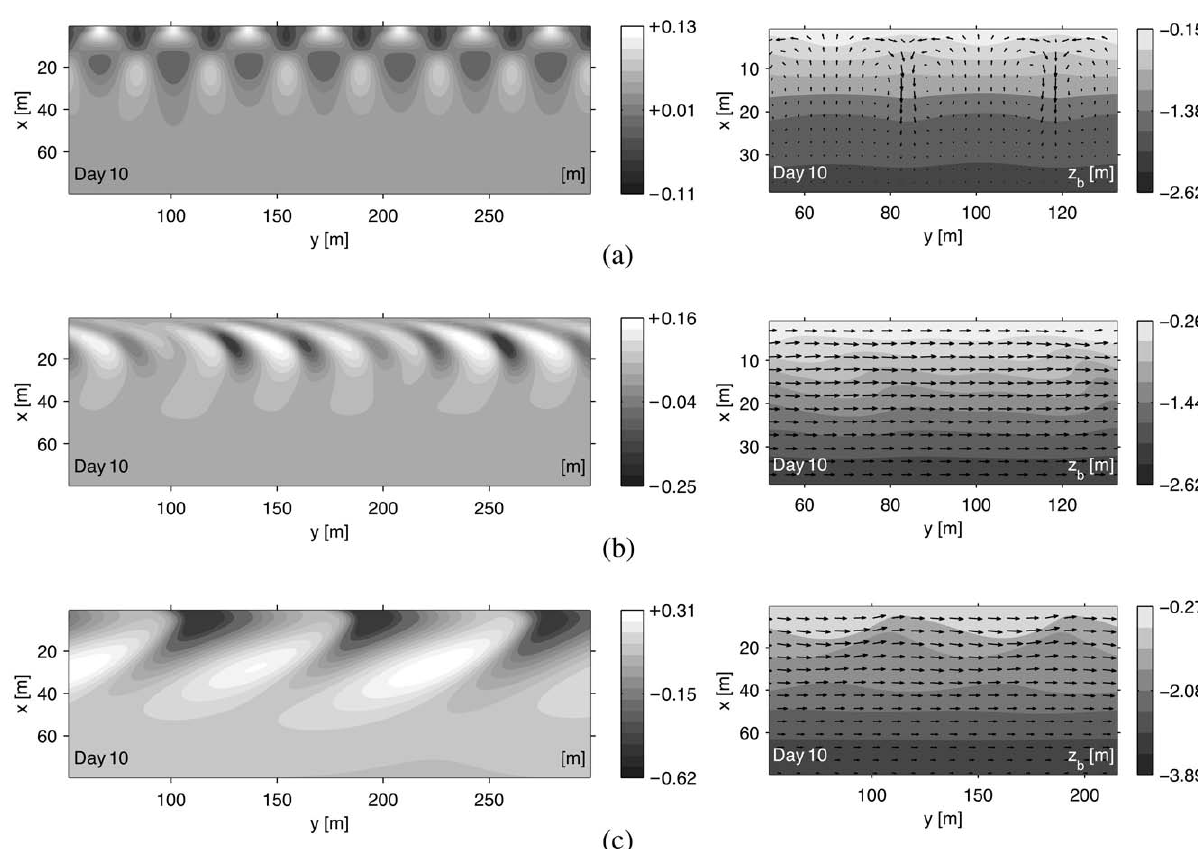
Fig . 9. – Final states (Day 10) of the different kinds of instabilities obtained for H 0 =1 m and T=9 s. Left: bed level perturbation h. Right: rms bed level z and current vectors. (a) Transverse bars (SVR sediment transport, θ 0 =0), maximum current 0.5 ms -1 . (b) Down-current oblique b bars (SVR sediment transport, θ 0 =10°), maximum current 1.4 ms -1 . (c) Up-current oblique bars (CWS sediment transport, θ 0 =10°), maximum current 1.2 ms -1